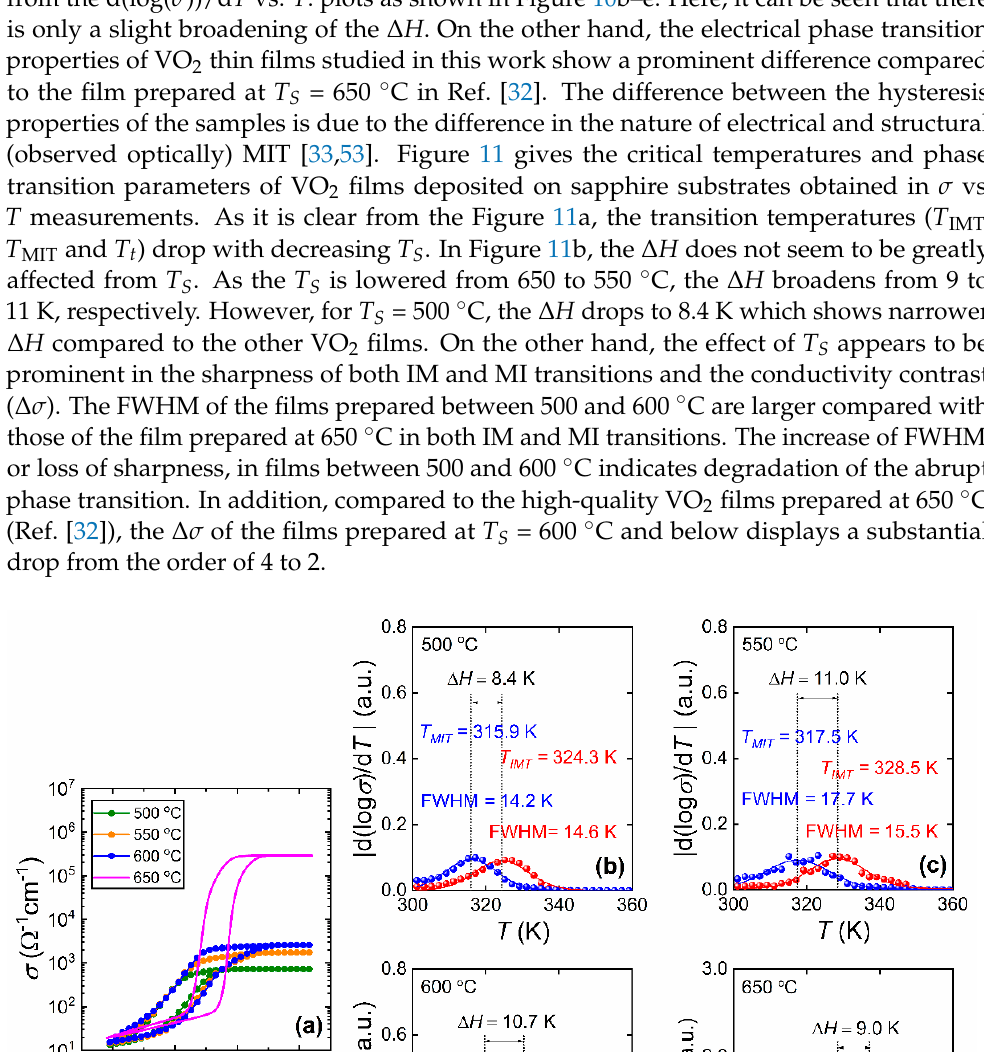
Figure 11. Electrical conductivity phase transition properties of VO 2 films prepared on sapphire substrates at various substrate temperatures ( T S ). ( a ) Critical temperatures of the phase transition ( T IMT , T MIT and T t ). ( b ) Phase transition parameters ( Δ H , FWHM (IMT), and FWHM (MIT)) and the contrast of conductivity, Δ σ = σ (368 K)/ σ (300 K). The data points for the substrate temperature 650 °C are from Ref. [32] and displayed in hollow symbols.